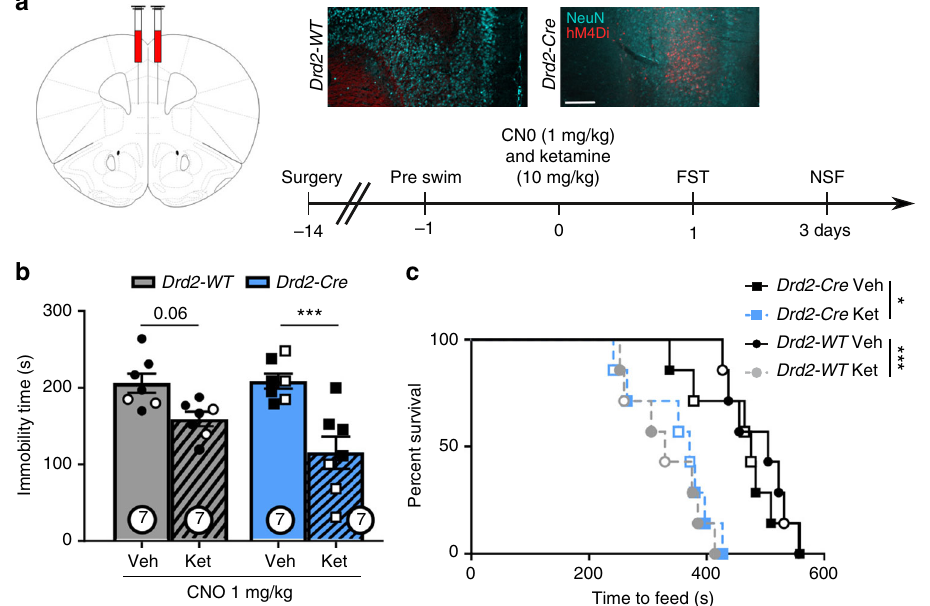
Fig. 4 mPFC Drd2- expressing cells are not necessary for the ketamine response. a Representative AAV-hM4Di viral expression in ventral mPFC. b Forced swim immobility time 24 h after hM4Di inhibition and ketamine (post-hoc t -test, p < 0.001). c Time to feed in novelty suppressed feeding test 72 h after photoinhibition and ketamine administration (Mantel – Cox (log rank) overall p < 0.0001, WT-veh vs. WT-ket p < 0.0001, Cre-veh vs. Cre-ket p < 0.05). n = 5 males, 2 females per WT group, n = 4 males, 3 females per Cre group; * p < 0.05, *** p < 0.001. Error bars represent mean ± SEM, scale bar 100 µ M. Male — closed data points, female — open data